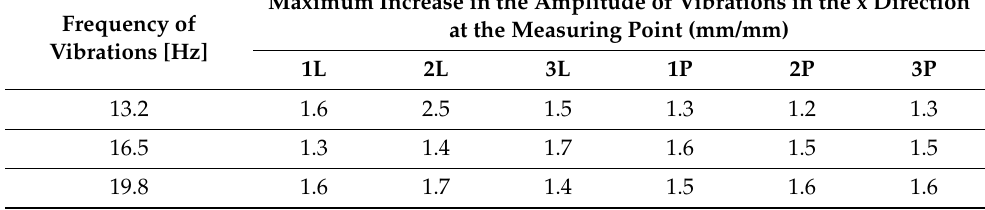
Table 7. Maximum multiples of vibration amplitude values in the x